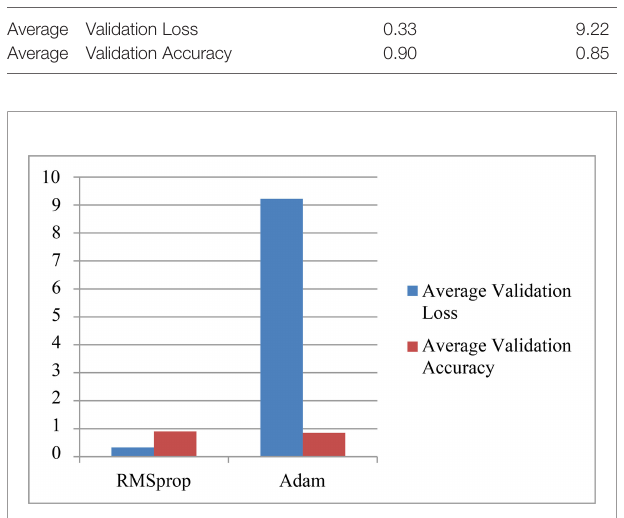
FIGURE 11 | Average Validation Values Obtained by using two Optimizer.